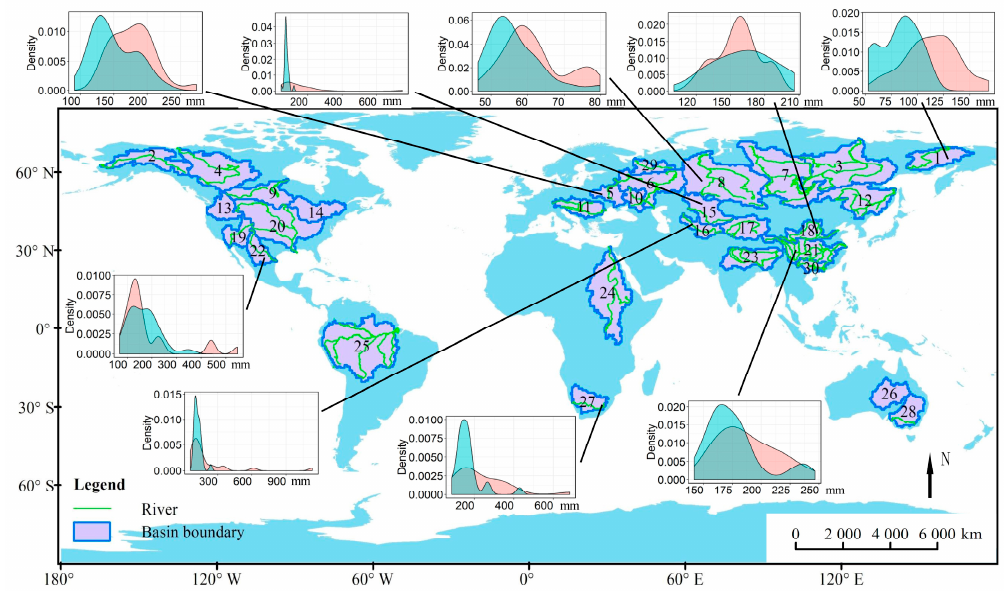
Figure 4. Changes in frequency distributions of RX1day for different river basins. The green and pink shadings in each panel represent the distributions for the period of 1960-1984 and 1985-2011, respectively. The x-axis in each panel shows amount of RX1day and the y-axis is the corresponding frequency distribution density.